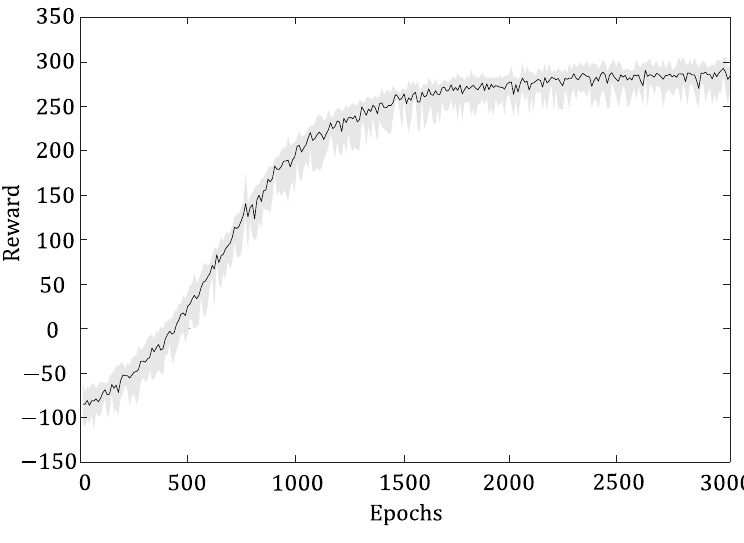
Figure 9. Reward profile.